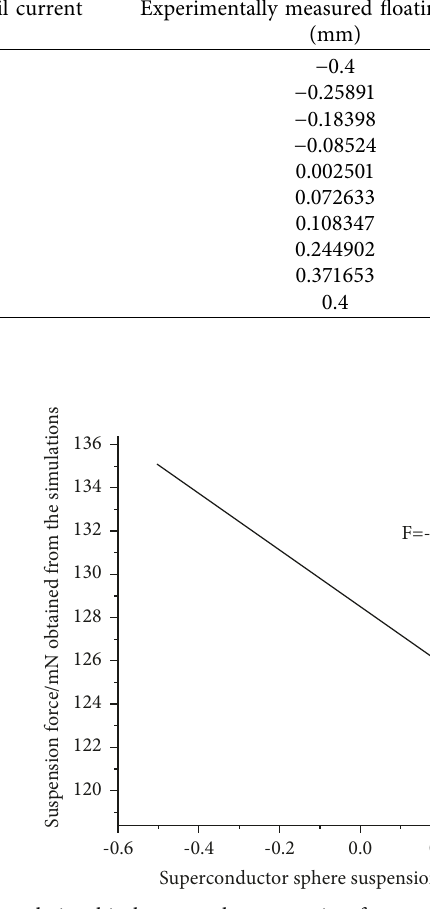
Figure 2: The relationship between the suspension force and the suspension position of the ball.